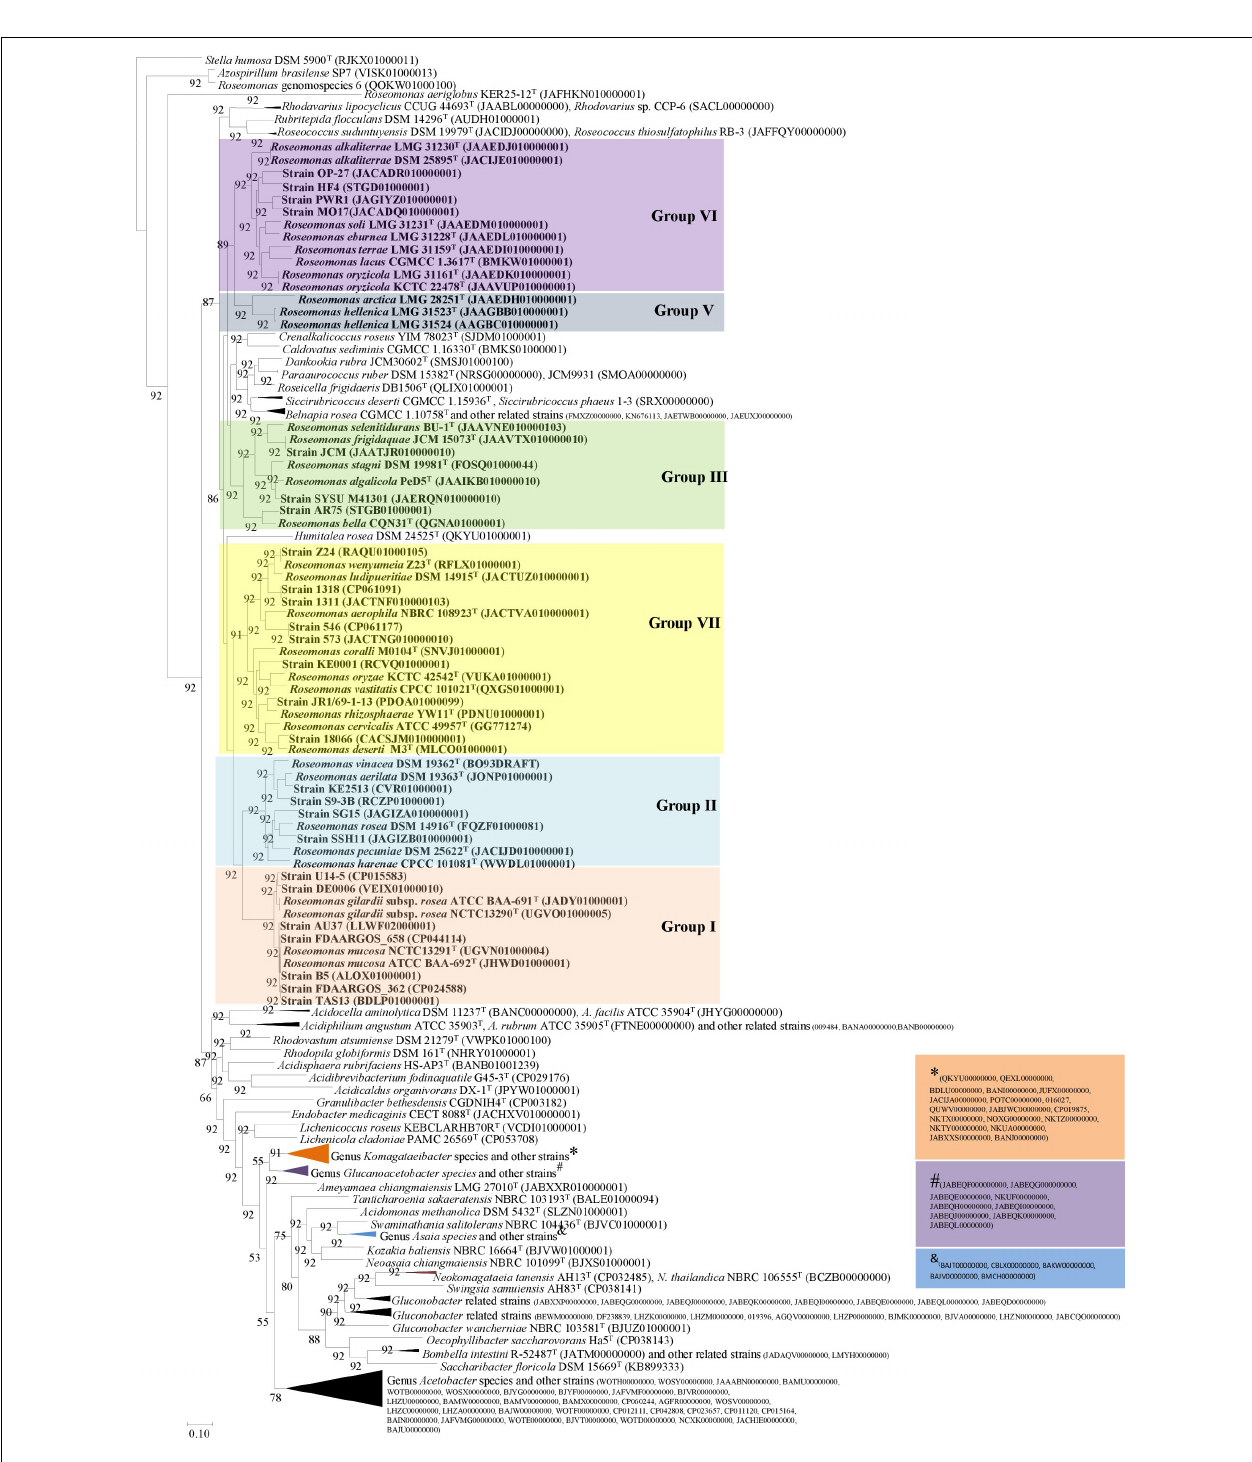
the other groups are either oxidase positive (Groups III, VI, VII) or negative (Groups IV, V). Members of Groups VI and VII have a high NaCl tolerance than members of the